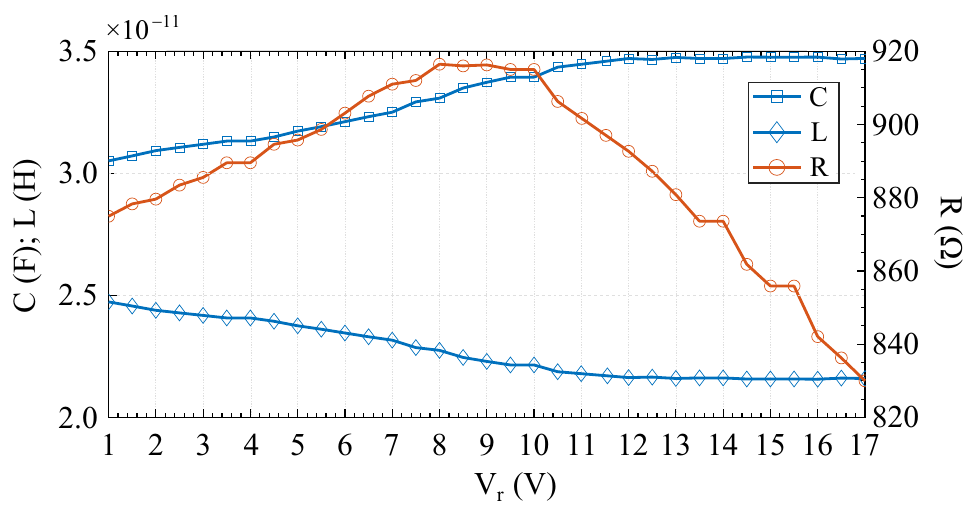
Figure 12. Values of the R , C and L equivalent circuit model components as functions of control voltage V r .